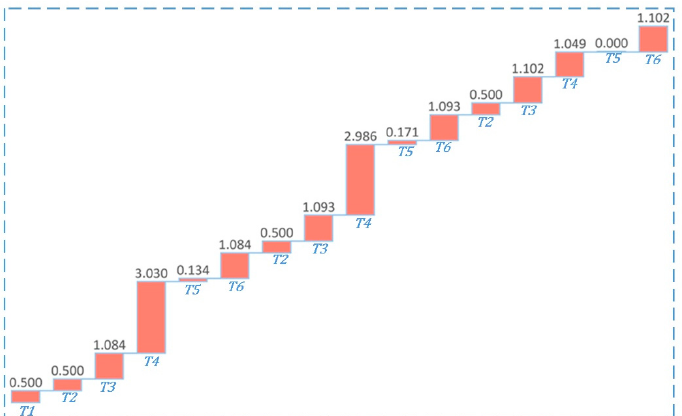
Figure 16. Average rescue time for each stage of the TPM-0.5 with 70 PDTs.